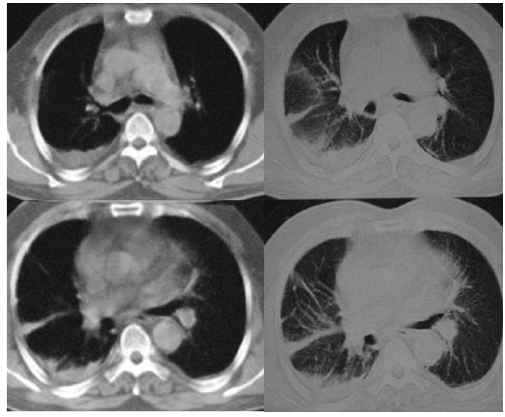
F 2: orax computed tomography showing the bilateral pleural effusion and linear atelectasis.